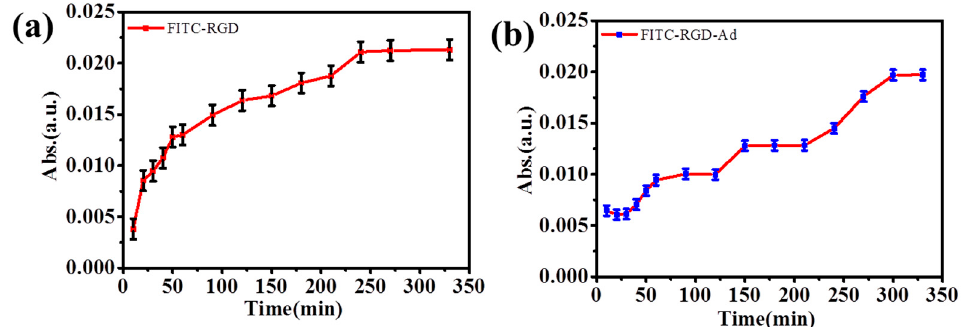
Figure 4. The release curves of ( a ) FITC–RGD and ( b ) FITC-RGD-Ad from (PAH/SiO 2 ) 1 /(PAH/HA-